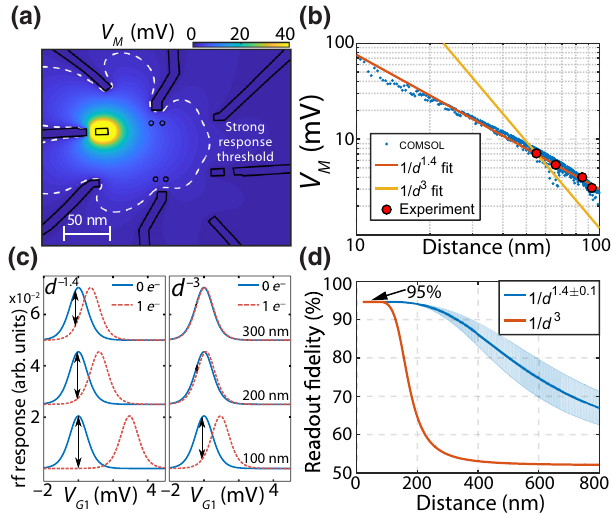
FIG. 3. Importance of the sensor shift V M for long-range qubit readout. (a) COMSOL simulation of V M for our device geometry. The dashed contour line indicates the estimated strong response regime boundary. (b) Fit to COMSOL simulated V M val- ues as a function of distance d from SLQD1. The simulated values (blue dots) follow a 1 / d 1.4 ± 0.1 dependence (orange line), which match the experimental values (red circles). The yellow line is a 1 / d 3 fit (as observed in planar gate-defined devices) to the experimental data, which is inconsistent with both the simu- lated and measured values. (c) Comparison of readout contrast possible for 100-, 200-, and 300-nm sensor-qubit distance for 1 / d 1.4 scaling (left panel) and 1 / d 3 scaling (right panel). At 300 nm, the sensor peaks for the two readout charge states are almost overlapping in the 1 / d 3 case, whereas significant discrimina- tion is still possible for 1 / d 1.4 . (d) Estimated single-shot readout fidelity as a function of qubit distance to SLQD1. The input parameters to the fidelity calculation (tunnel rates, T 1 relaxation time, noise level) are taken from the experimentally measured values for D 3. The blue curve is for 1 / d 1.4 ± 0.1 , with the shaded region outlining the uncertainty bounds from the fit in Fig. 3(b). The orange curve is for 1 / d 3 , and exhibits a much faster roll-off in readout fidelity. Over 90% fidelity is possible out to 300 nm for 1 / d 1.4 , compared to 130 nm for 1 / d 3